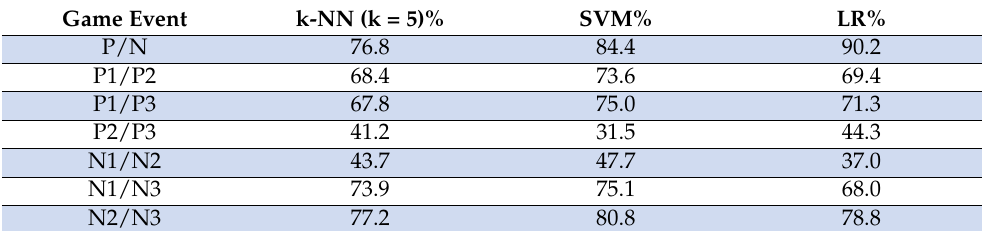
Table 3. The recognition accuracy of